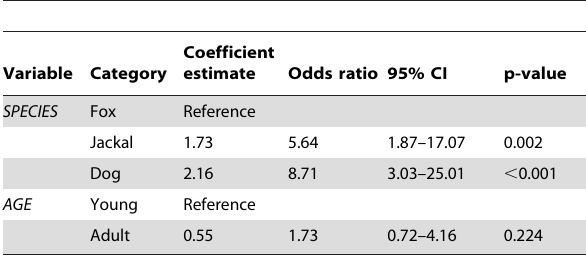
Table 8. Multivariate analysis* of factors associated with Bartonella serostatus in Iraqi